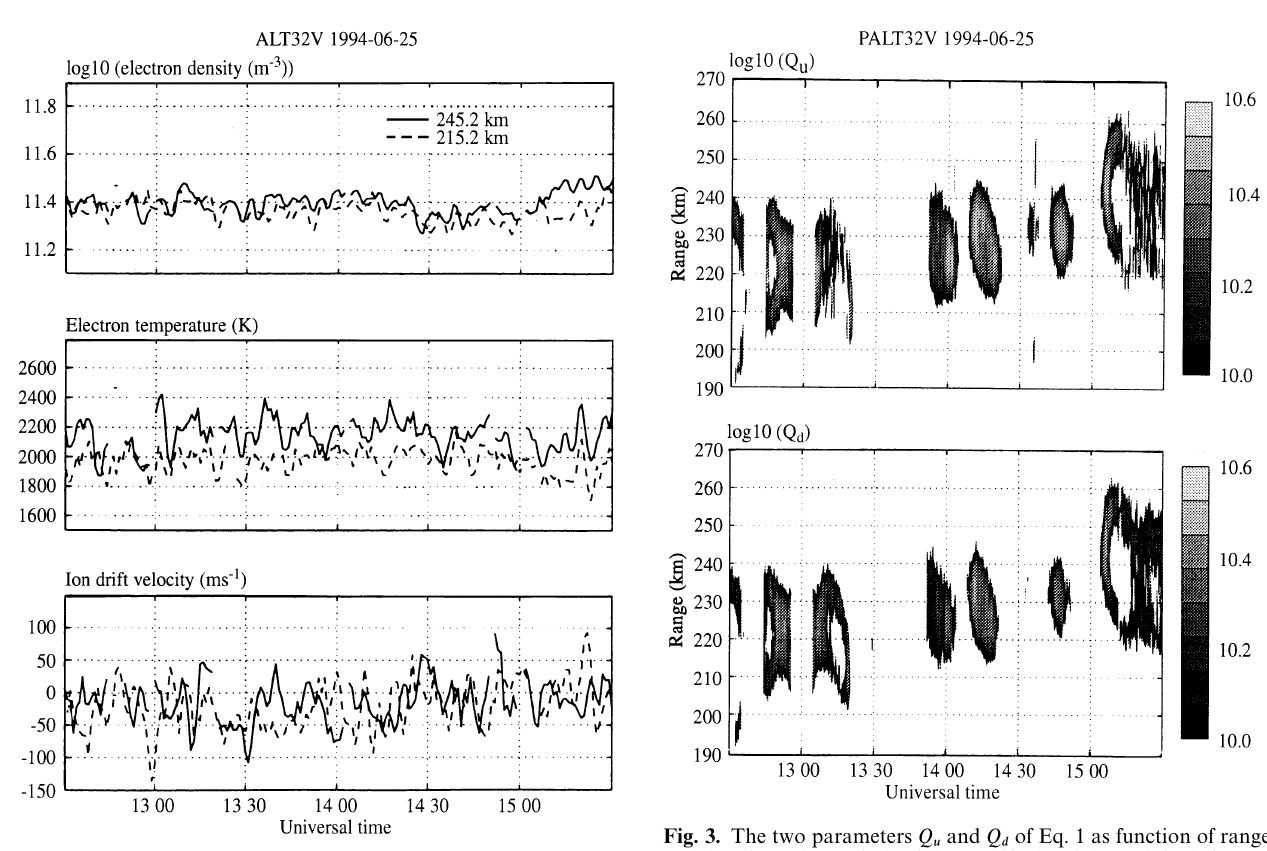
Fig. 2. Ionospheric parameters as function of range and time from the analysis of the ion line. The data have been smoothed with a 9 km (cid:93) 30 s window